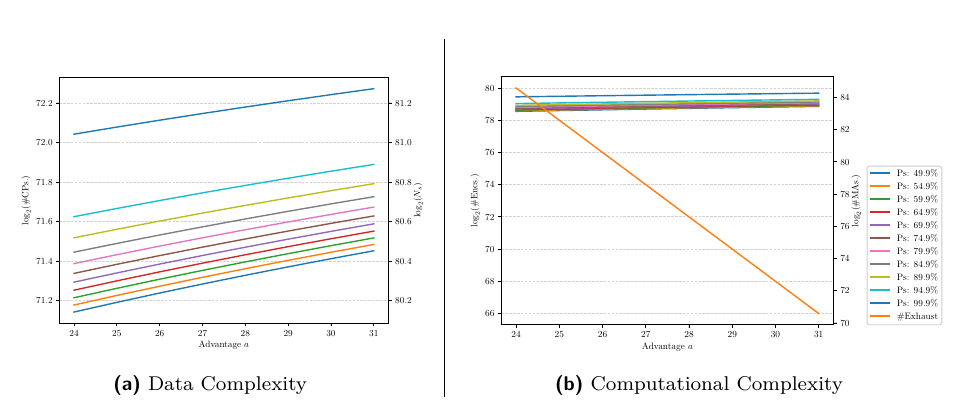
Figure 5: Relations between success probability, advantage, data complexity, and computational complexity of the attack using the model in [SS17]. Note that in our attack, log log ( N ) − 41 + 32, and we assume #Encs . ’ 6 · 4 · #MAs . . 2